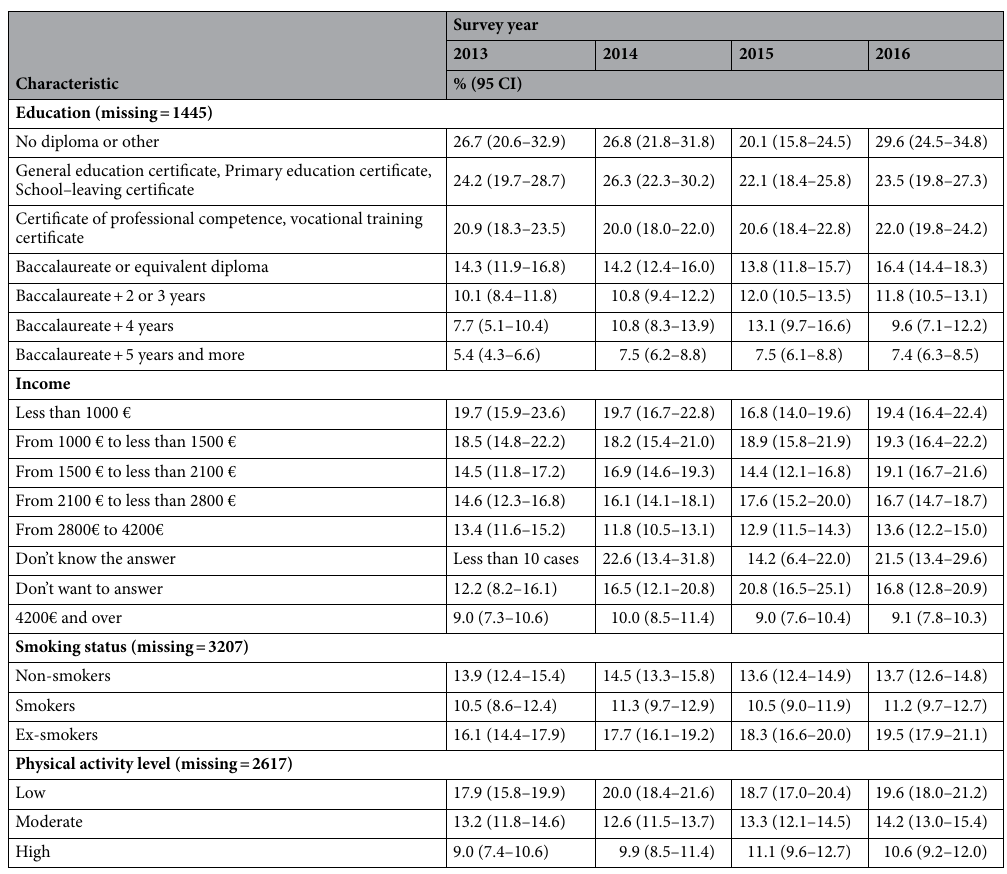
Table 4. Prevalence of obesity by income, education, smoking and physical activity level (N = 63,582). Age and sex-adjusted by the raking ratio method using the Insee data and age groups 18–29, 30–39, 40–49, 50–59, and 60–69